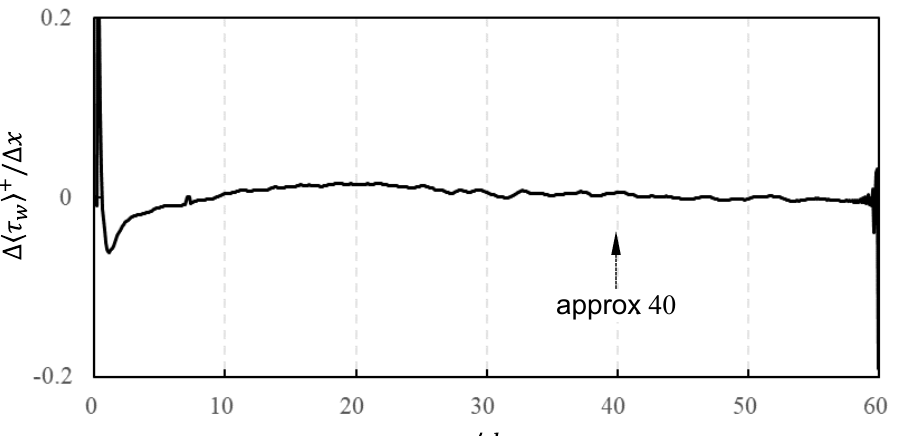
Figure 5. Variation of dimensionless wall shear stress per grid size.